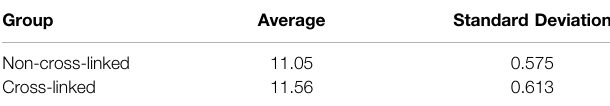
TABLE 3 | Results from the 1658/1690 cm − 1 ratio comparison between non- cross-linked and cross-linked, hydrated collagen